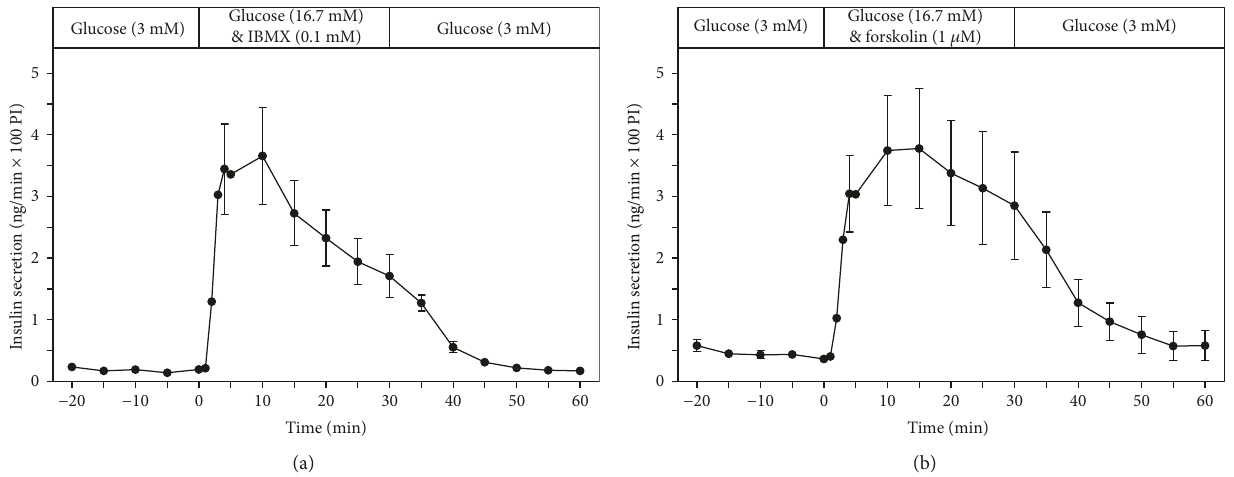
Figure 2: Kinetic pro fi les of insulin secretion from perifused EndoC- β H1 β -cell pseudoislets in response to a 30 min stimulation with glucose (16.7 mM) (a) ( n = 7 ) in the presence of adenylate cyclase activators IBMX (0.1 mM) (a) ( n = 5 ) and forskolin (1 μ M) (b) ( n = 4 ). After a 20min preperifusion phase with basal glucose (3 mM), a 30min stimulation period and thereafter a return of the perifusion to basal glucose medium for another 30min are depicted. Shown are means ± SEM of insulin release rates expressed as ng/min and per 100 pseudoislets (PI).